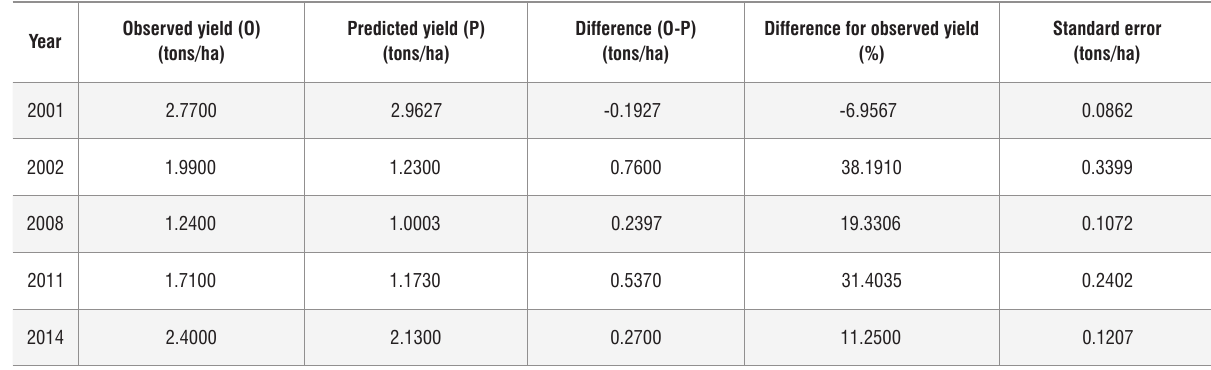
Predicted yield (P) (tons/ha)